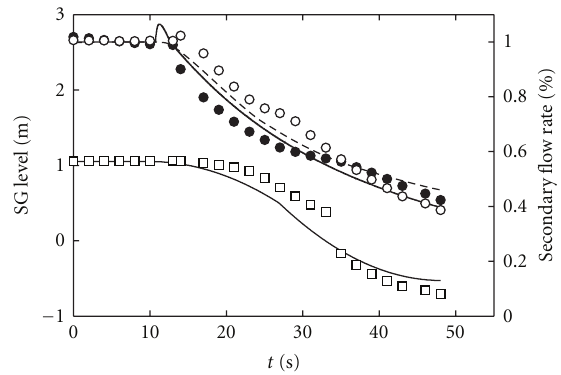
Figure 9: Event 2. Evolution of the steam-generator water level, the feedwater flow (full circles and solid curve), and the steam flow (empty circles and dashed